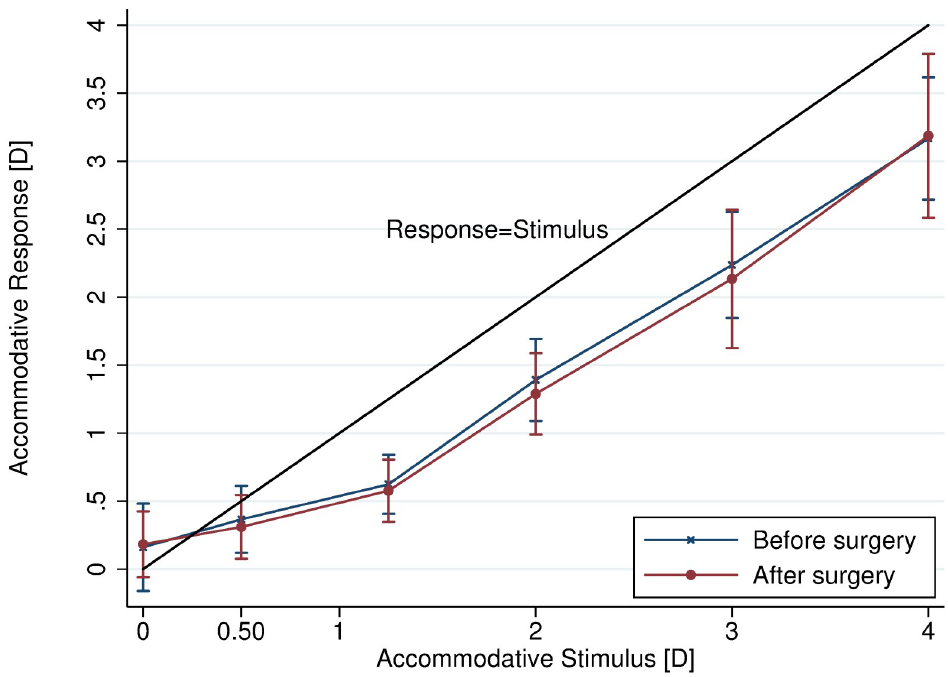
Fig 3. Practically equal accommodative response-stimulus curves before and after surgery. Accommodative lead is seen for 0 D and increasing lag is seen with increasing stimulus. Error bars represent ± 1 standard deviation. Function y = x shown for